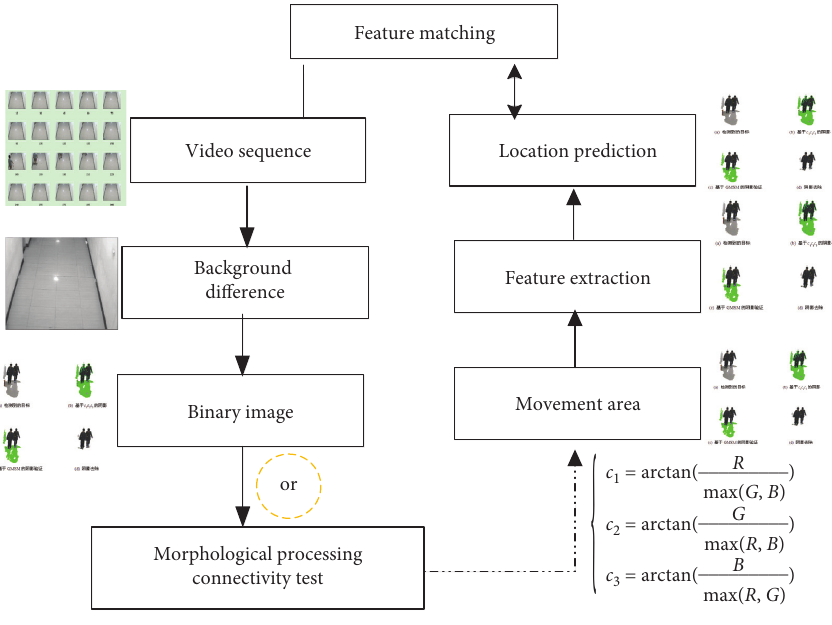
Figure 2: The flowchart of the training target